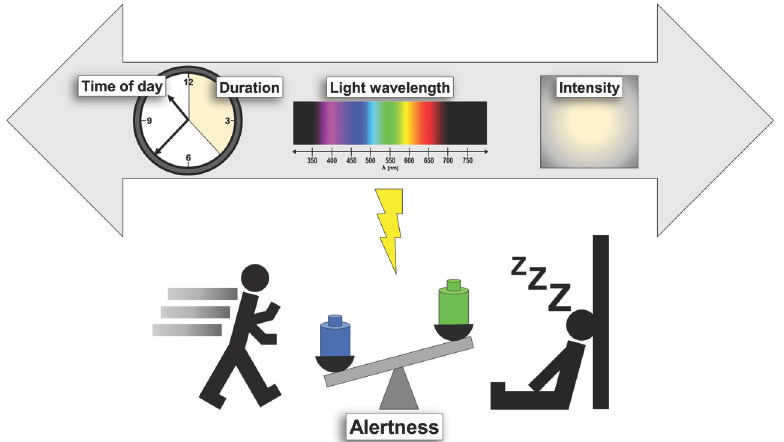
Fig 1. Summary of light parameters influencing sleep and alertness in humans. In humans, light exerts strong alerting effects that depend upon several parameters, such as dose (irradiance), duration, and the time of day of light exposure. This photic regulation of alertness also critically depends on the spectral composition of light, with blue light as a powerful alerting stimulus, contrary to green light, which might be less powerful to awaken a subject from